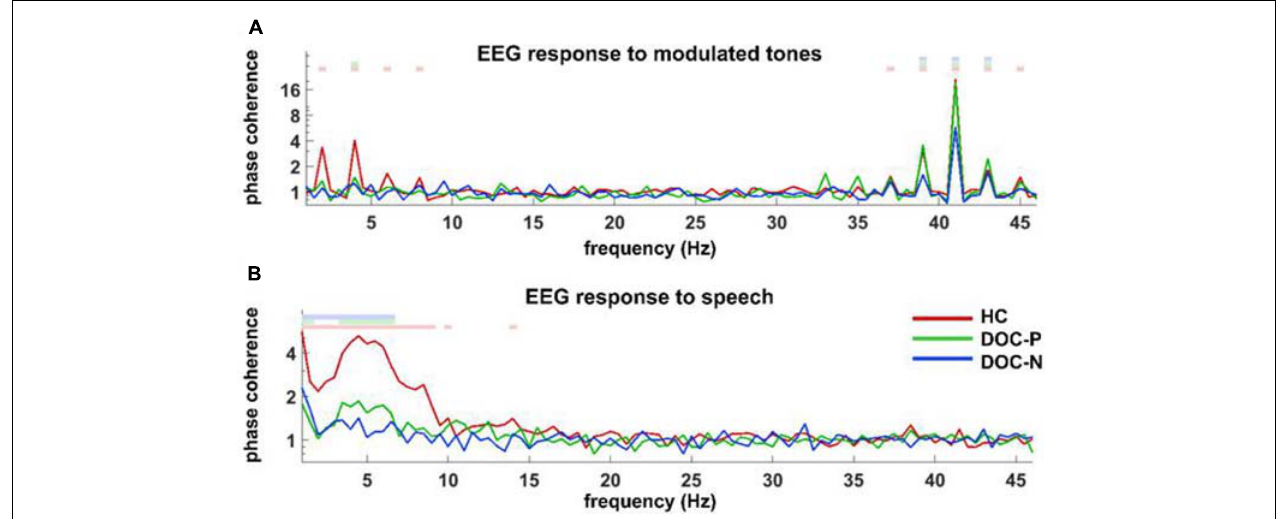
FIGURE 1 | Phase coherence spectrum for responses to modulated tones (A) and speech (B) in the group of healthy controls (HC), patients with positive prognosis (DOC-P), and patients with negative prognosis (DOC-N). (A) Coherences to modulated tones at 41 and 41 ± 2 Hz were significant in HC, DOC-P, DOC-N, and there seemed to be no difference between HC and DOC-P. (B) Speech tracking response in delta and theta frequency bands for the group of healthy controls (HC) was significantly different from that of DOC-P group. The colored squares on top denote the frequency bins in which phase coherence is significantly higher compared with chance ( P < 0.01, bootstrap, FDR